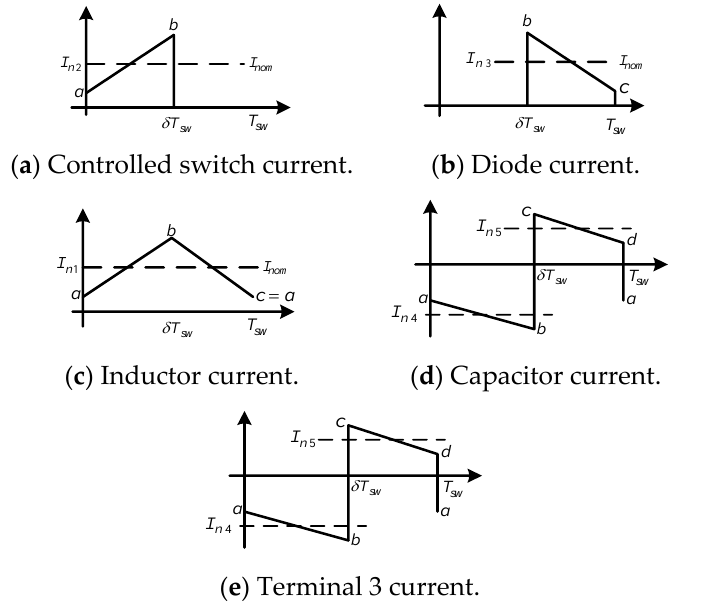
Figure 8. Current signals generated at various terminals of DC – DC converters derived from cells 1-4 .